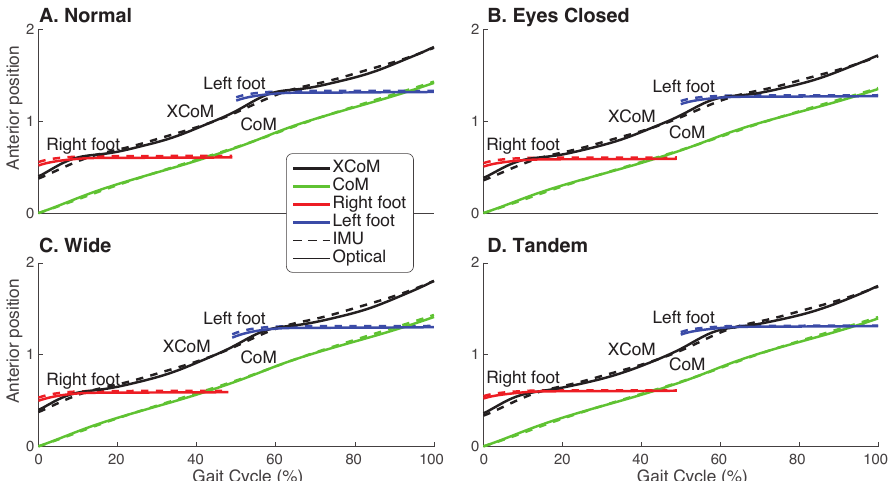
Figure A1. Anterior-posterior trajectories over a gait cycle for both IMU and Optical. Mean AP XCoM (black), CoM (green), and right (red) and left (blue) BoS for each walking condition of ( A ) Normal, ( B ) Eyes Closed, ( C ) Wide, and ( D ) Tandem, as measured by the IMU (dashed) and Optical (solid) motion-capture systems ( N = 10). The BoS was determined from anterior foot positions. The gait cycle is shown as a percentage of stride from right heel strike to right heel